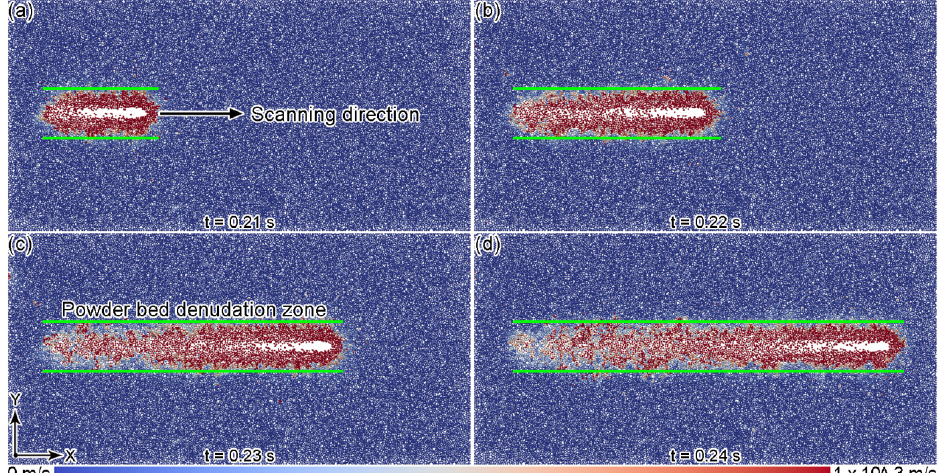
Figure 5. Powder bed denudation zone at different moments in Scheme B: ( a ) t = 0.21 s; ( b ) t = 0.22 s; ( c ) t = 0.23 s; ( d ) t = 0.24 s.